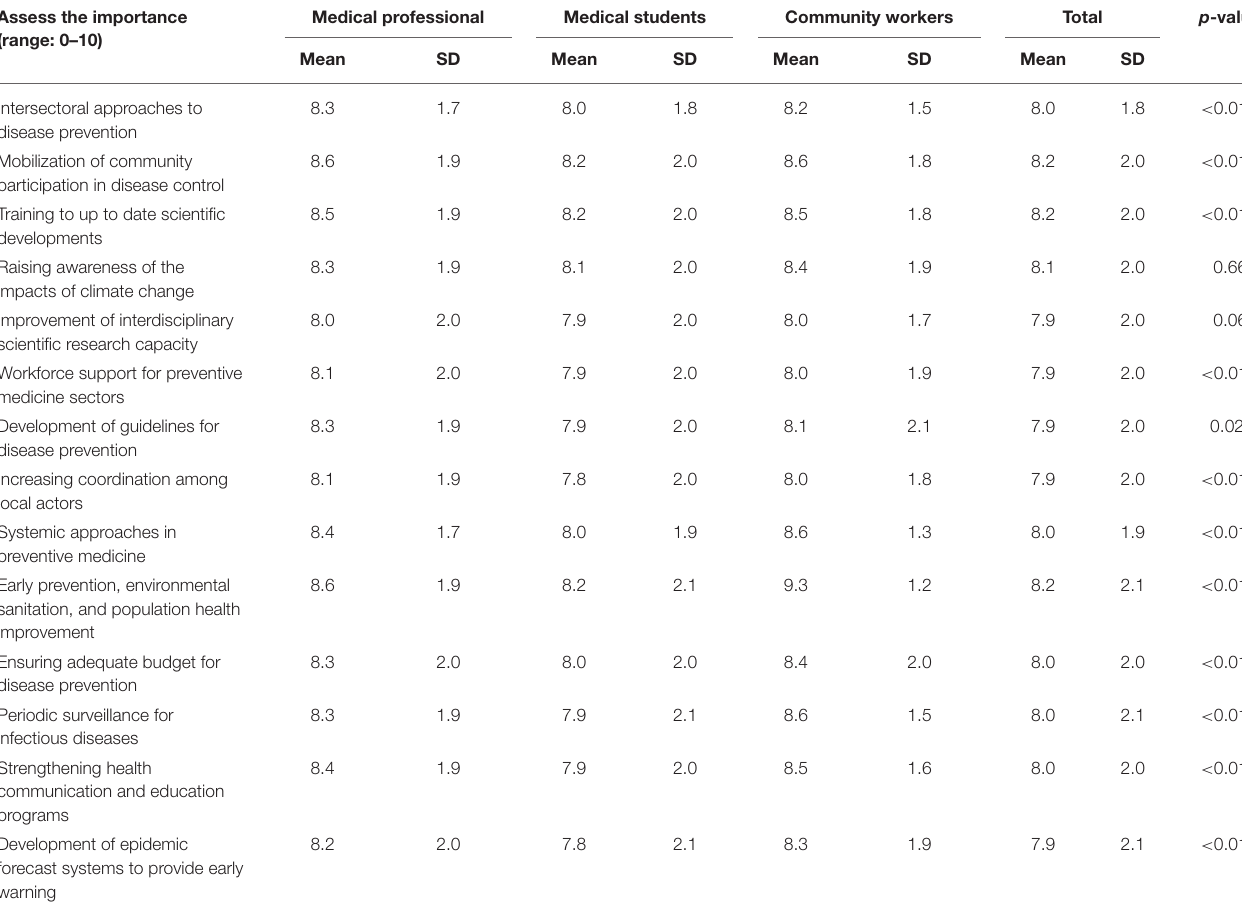
TABLE 3 | Assessing the importance of local disease control measures of health workers and medical students in Vietnam, 2020. Assess the importance Medical professional Medical students Community (range: 0–10)